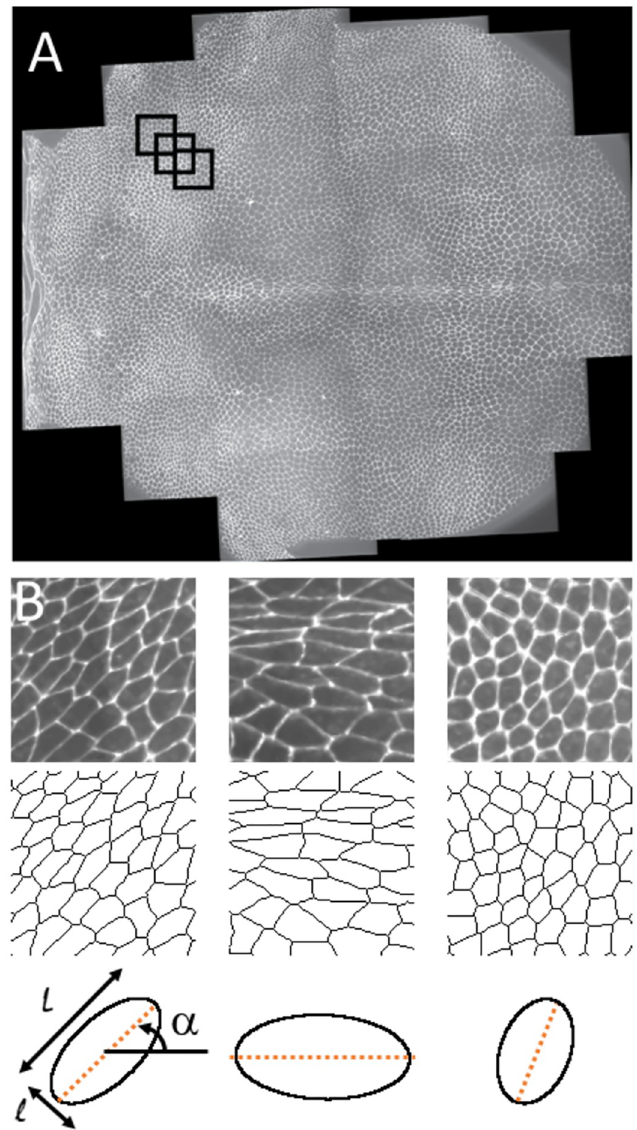
Fig 1. Illustration of the problem. A: full raw image of the Drosophila dorsal thorax. Small black circles represent the size of the images used in our models. B: three examples of such images along with their segmented counterparts and representations of the average cell shapes with the three key targets: long axis L, short axis l and orientation α .